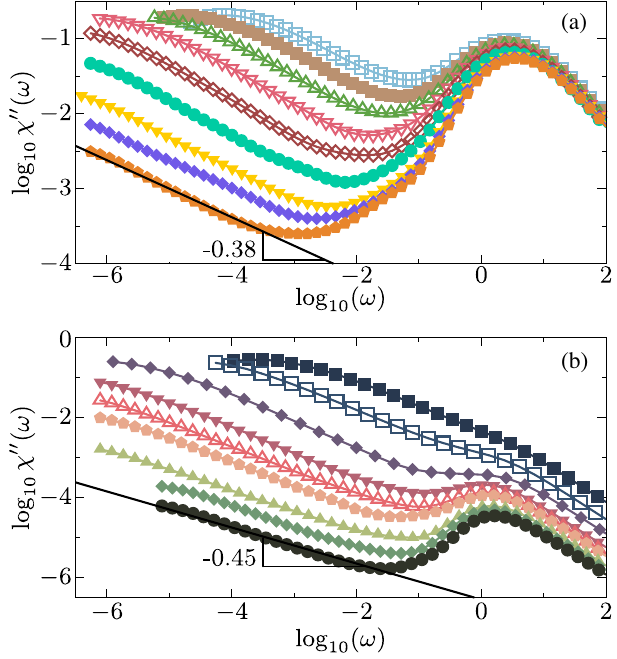
FIG. 11. Emergence of excess wings in relaxation spectra near T . Equilibrium relaxation spectra χ 00 as a function of the g frequency ω in (a) 3D and (b) 2D. The black lines are power-law fits χ 00 ð ω Þ ∼ ω − σ with σ ≈ 0 . 38 (in 3D) and σ ≈ 0 . 45 (in 2D). Legend as in Fig.